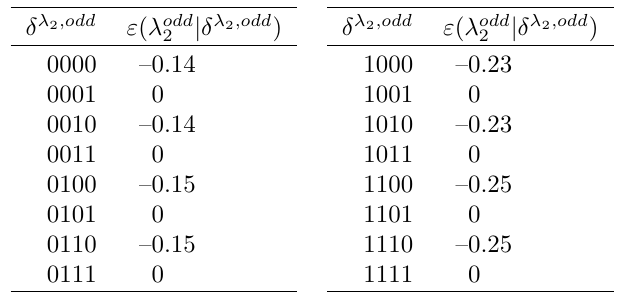
Table 6: Conditioning ε ( λ 2 odd ) on Each of the 16 Values of δ λ 2